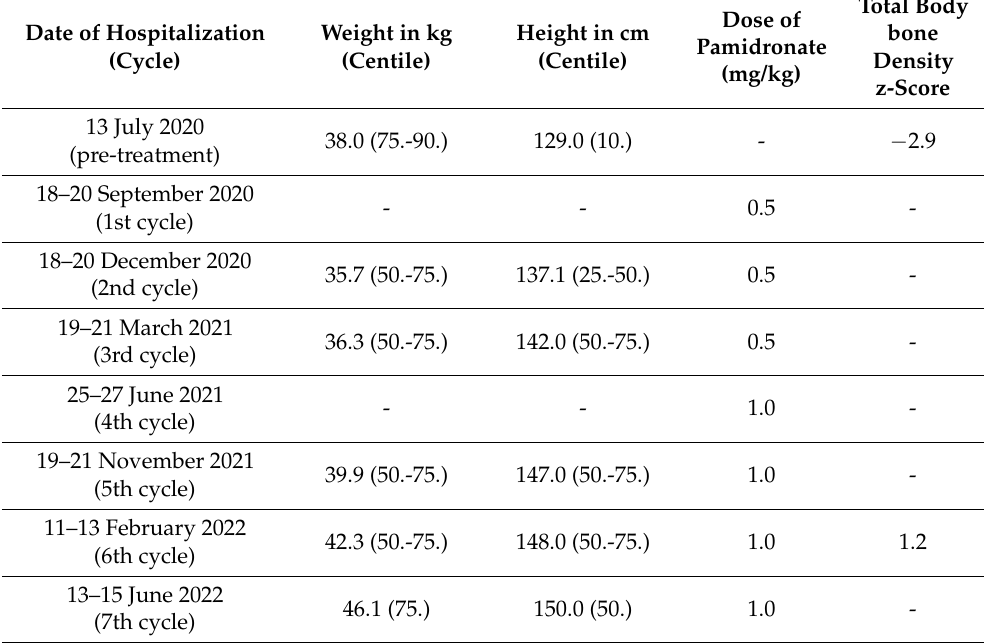
Table 2. Summary of patient’s course of